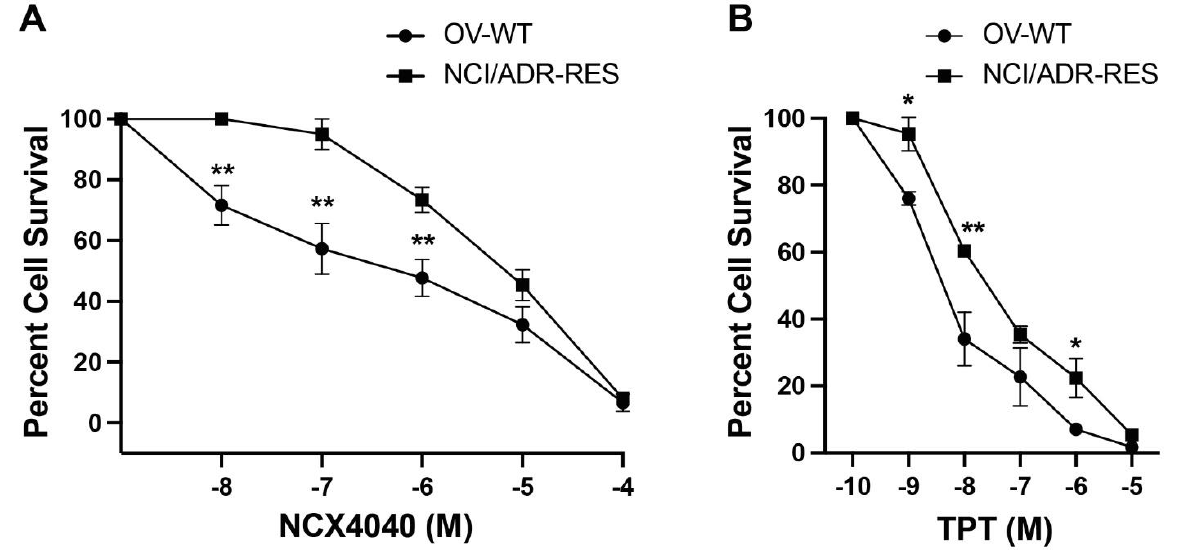
Figure 2. Cytotoxicity of NCX4040 in ( A ) and topotecan (TPT, ( B )) in WT OVCAR-8 and NCI/ADR- RES cells at 48 h drug exposures, respectively. * p and ** p -values, <0.05 and <0.005, respectively, compared to concentration-matched treatment.